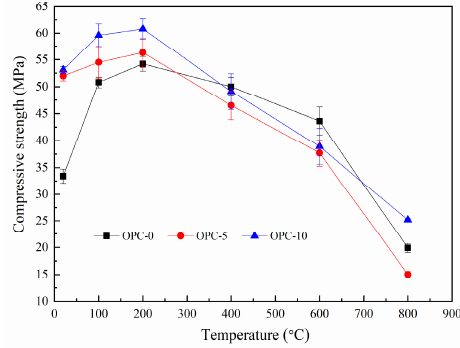
Figure 7. Residual compressive strength of low-calcium FAGC.